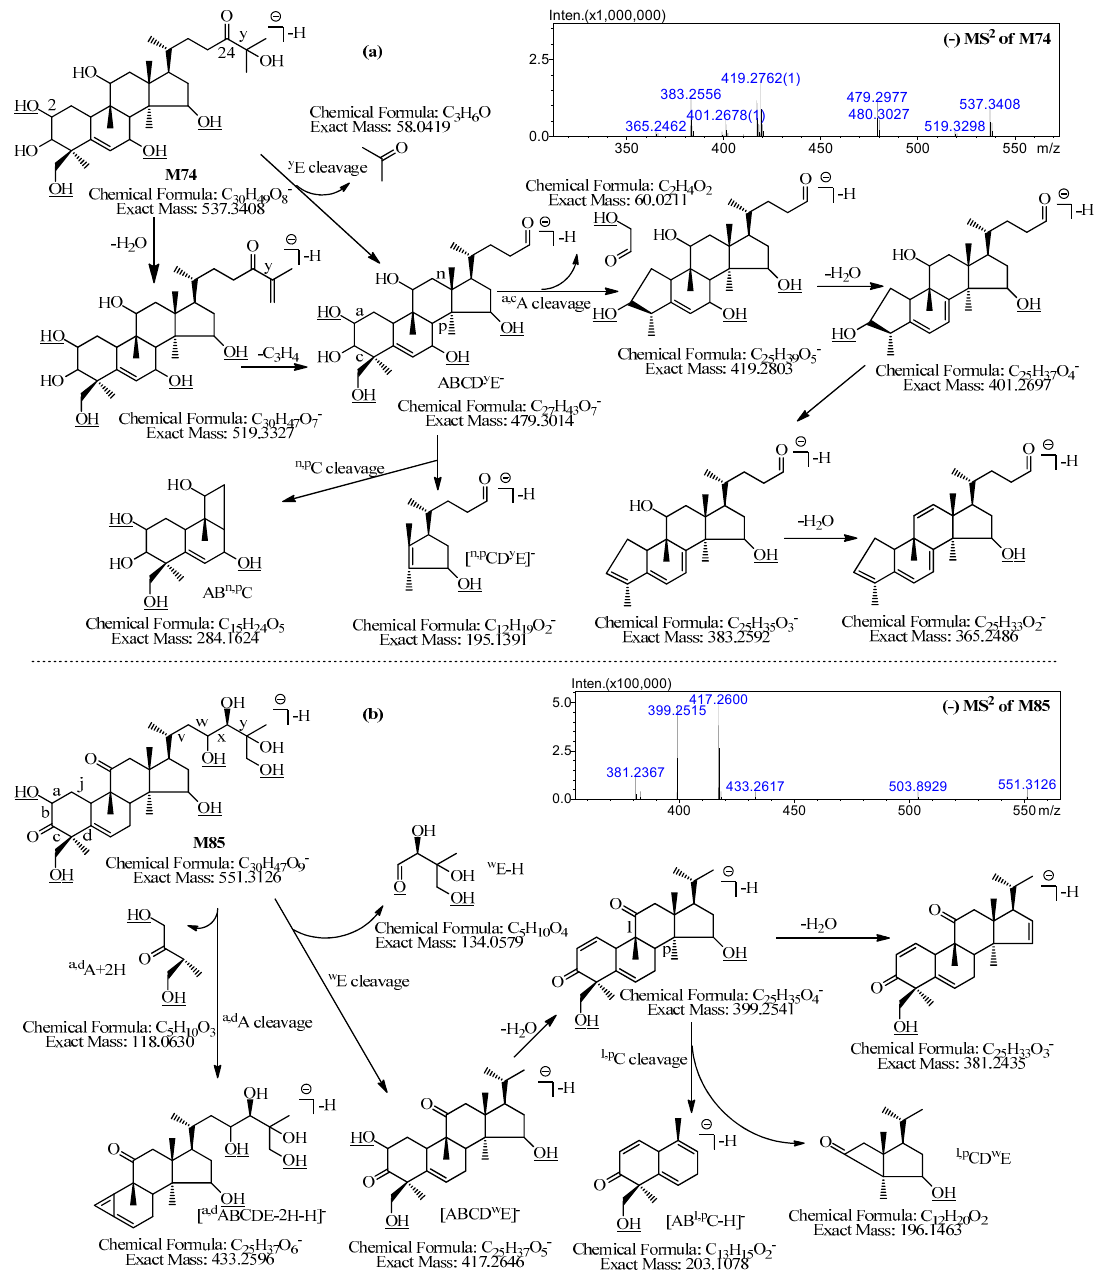
Figure 3. The MS 2 spectra, characteristic fragment ions, and proposed fragmentation pathways of M74 and M85 . ( a ) M74 ; ( b ) M85 .